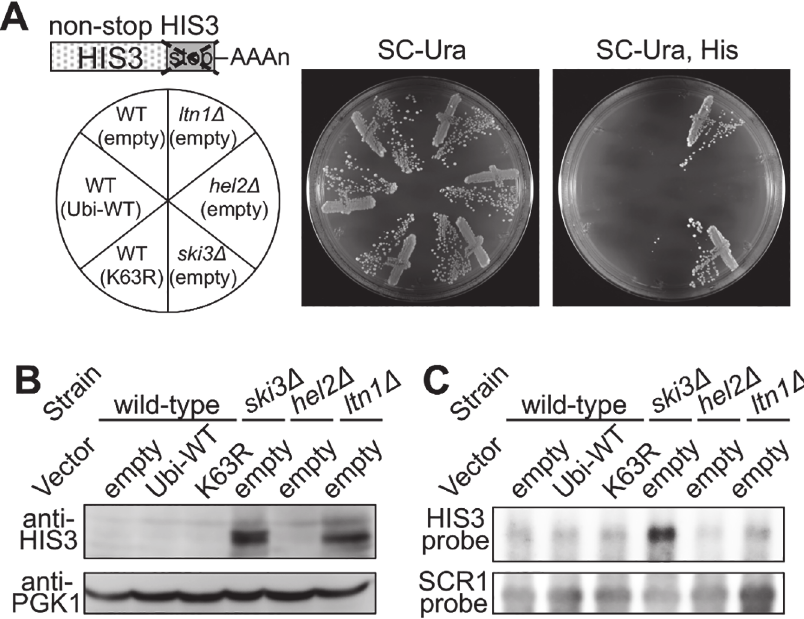
Fig 7. Effects of K63 polyubiquitination and Hel2 on quality control for non-stop translation. (A) Genetic colony growth test for the nonstop HIS3 reporter. A schematic image of a nonstop HIS3 allele is illustrated above. Empty vector (empty), wild-type ubiquitin (Ubi-WT), or K63R ubiquitin (K63R) plasmids were introduced into the wild-type, ski3 Δ , hel2 Δ , or ltn1 Δ strains harboring nonstop HIS3 reporter (S17-A08, S17-A09, SKY123, SKY137). Types of knockout alleles and vectors are indicated on the left. Transformant colonies were streaked on the SC-Uracil (Ura) (middle), and SC-Uracil, Histidine (Ura, His) (right) plates, and colony growth was monitored for 3 days at 30°C. (B) Western blot analysis for the nonstop HIS3 reporter. Protein samples were extracted from the transformants of the nonstop HIS3 reporter strains as in (A). The expression of HIS3 protein was detected using a HIS3 polyclonal antibody. PGK1 was used as a loading control. (C) Northern blot analysis for the nonstop HIS3 reporter. mRNA samples were extracted from the transformants of the nonstop HIS3 reporter strains as in (A). The nonstop HIS3 reporter mRNA was probed by HIS3 complementary DNA fragment. SCR1 mRNA was detected as a loading